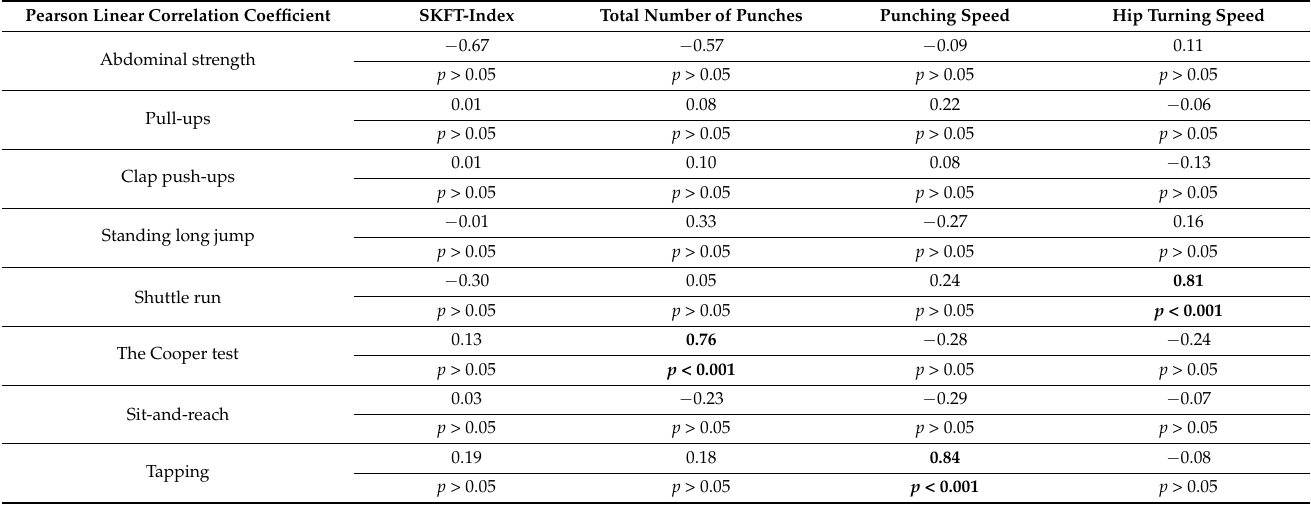
Table 5. Relationships between special physical fitness and general physical fitness of kickboxers after the experimental